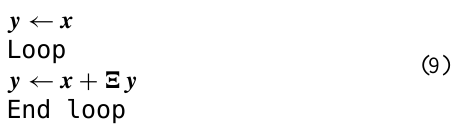
Algorithm 1. Approximate matrix